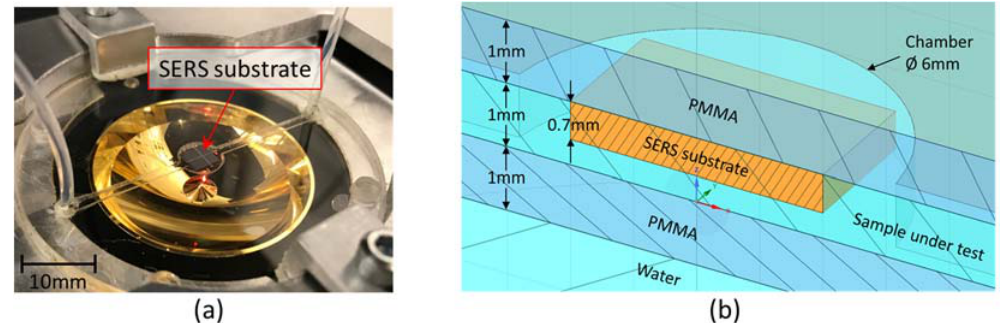
Figure 7. ( a ) Microfluidic chip integrated with SERS substrate to enhance the sensitivity of the Raman analysis. ( b ) Cross-section of the SERS microfluidic Chip.